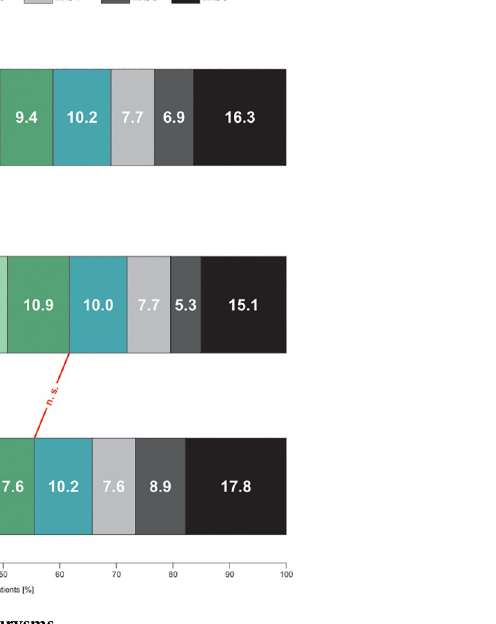
Fig 1. Outcome in right- and left- sided